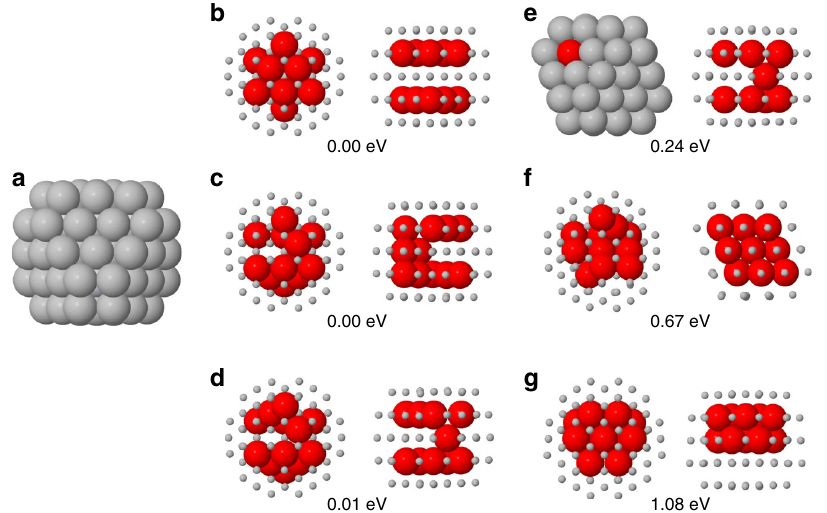
Fig. 4 DFT results. a The truncated octahedron of 79 atoms. This structure has 19 internal sites, i.e. 18 subsurface sites plus the central site. b – g Structures of Ag 67 Pt 12 . Each cluster is shown in two views. Pt atoms are in red and Ag atoms in grey. Pt and Ag atoms are shown as large and small spheres, respectively, with the exception of the left view of ( e ), in which all atoms are shown as large spheres. In ( b ), the perfect L1 1 @Ag-skin phase is shown. The numbers give the DFT energy differences from the lowest-energy homotops, which are the perfect L1 1 @Ag-skin structure shown in ( b ) and the structure in ( c ). DFT density functional theory